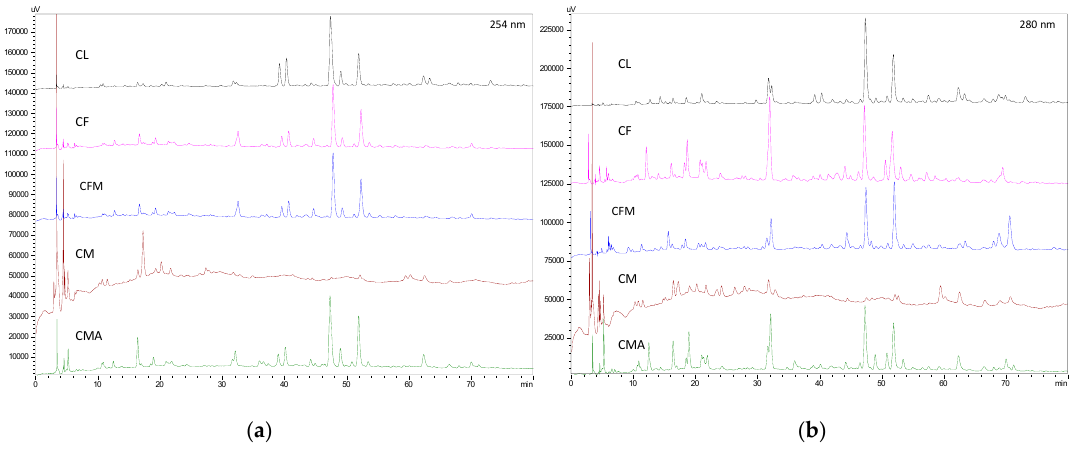
Figure 1. HPLC-DAD chromatogram of five Japanese dodder parasitizing on different plants, D. longans Lour. (CD), F. septica Burm. f. (CF), F. microcarpa L. f. (CFM), M. micrantha H. B. K. (CM), and M. azedarach Linn (CMA), respectively. Wavelengths: 254 nm ( a ) and 280 ( b ) nm.